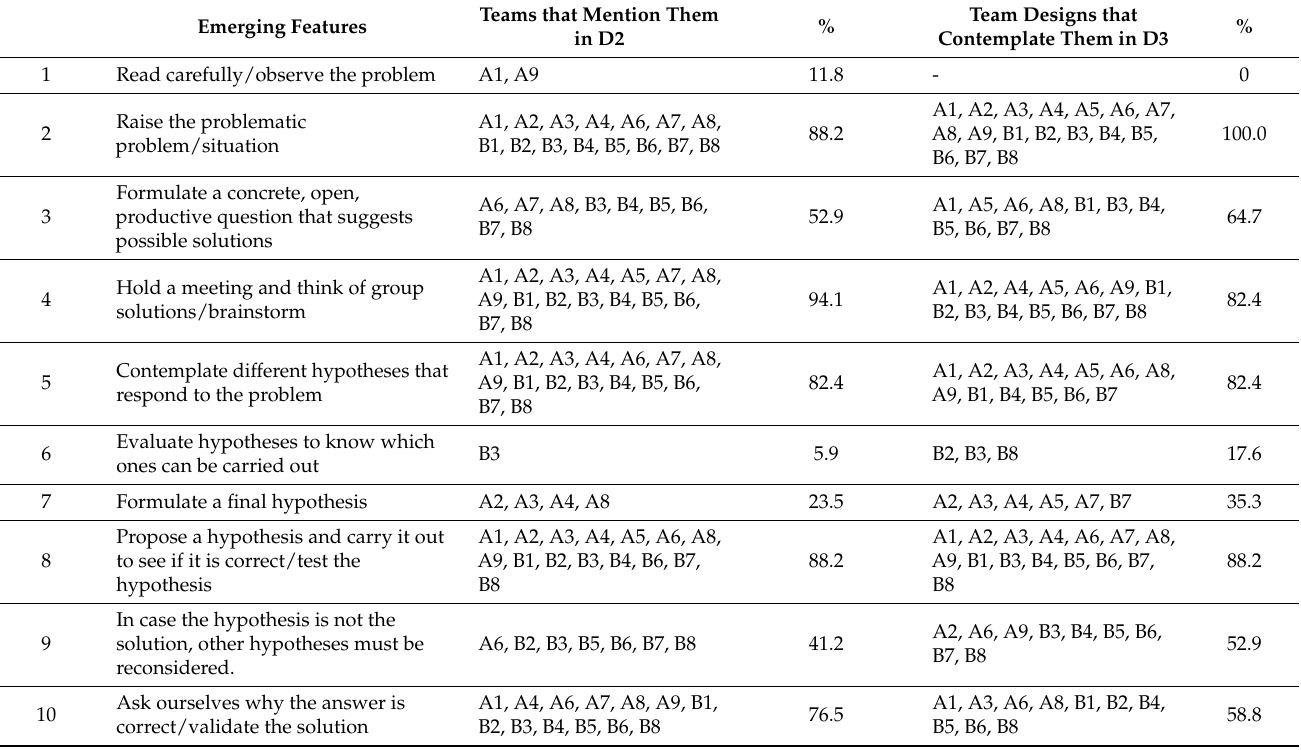
Table 5. Characteristics of didactic problems in robotics problem